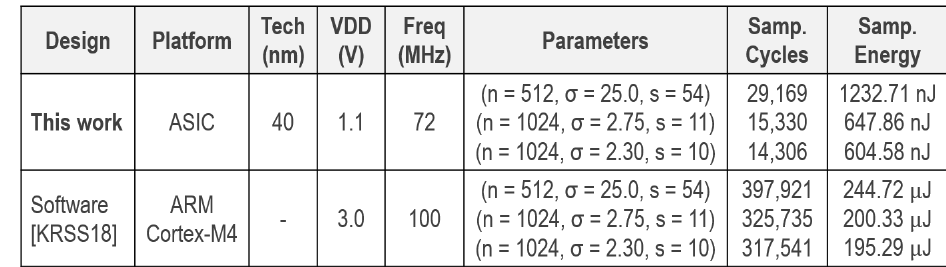
Table 6: Comparison of discrete Gaussian sampling with